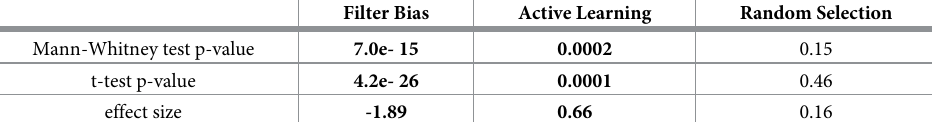
Table 16. Results of the Mann-Whitney U test and the t-test comparing the size of the class-1-blind spot for the three forms of iterated algorithmic bias with the Movielens data set. The negative effect size indicates that filter bias leads to a bigger blind spot. Both random selection and active learning do not have a significant impact.